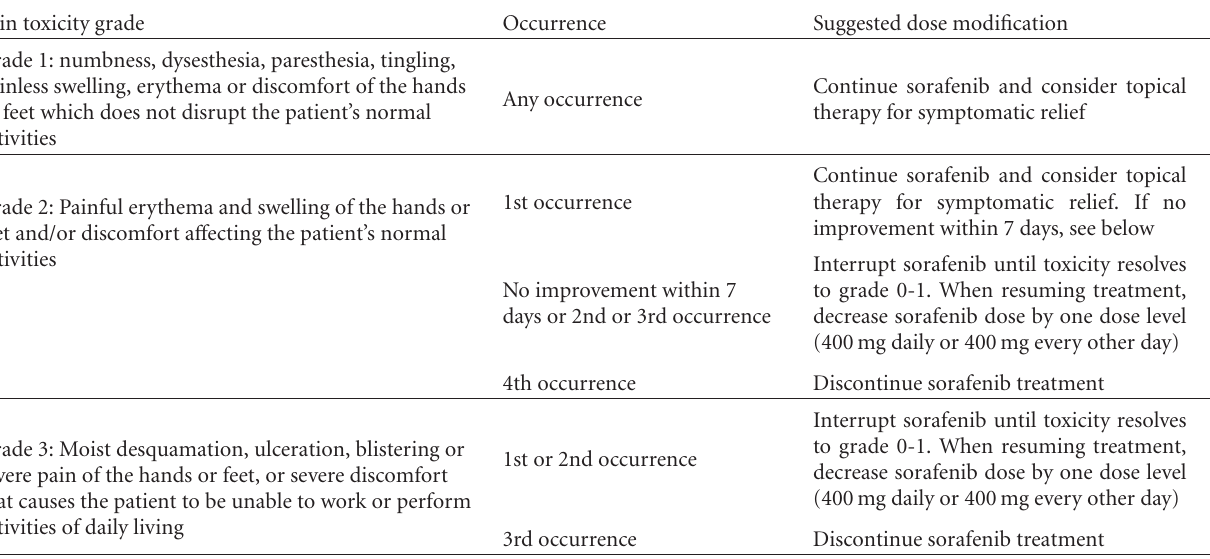
Table 3: Suggested dose modification for skin toxicity for sorafenib